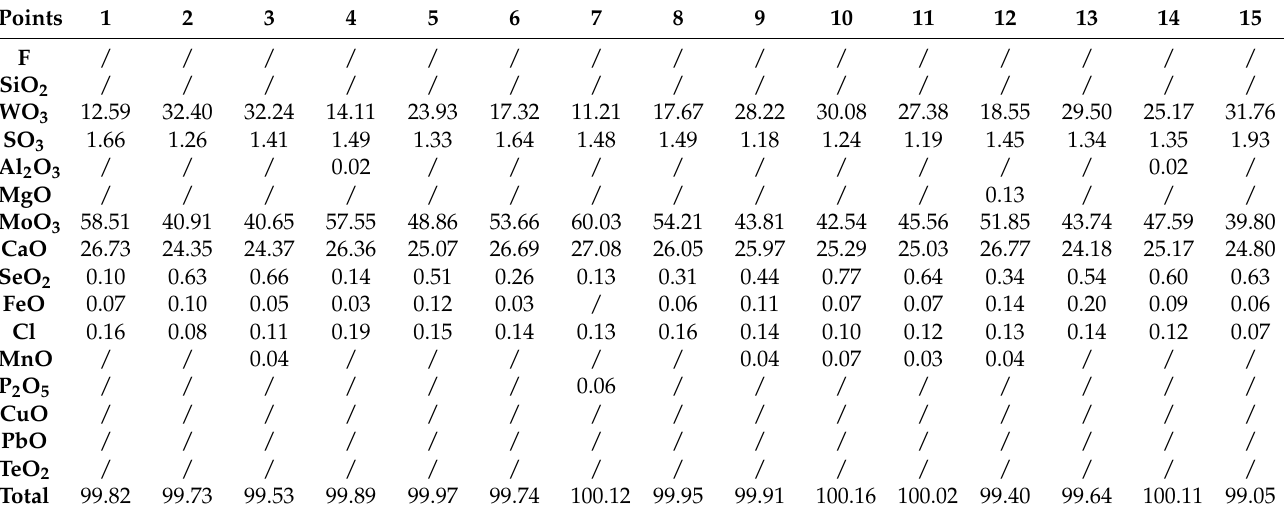
Table 2. Representative analysis results (wt.%) of Mo oxide